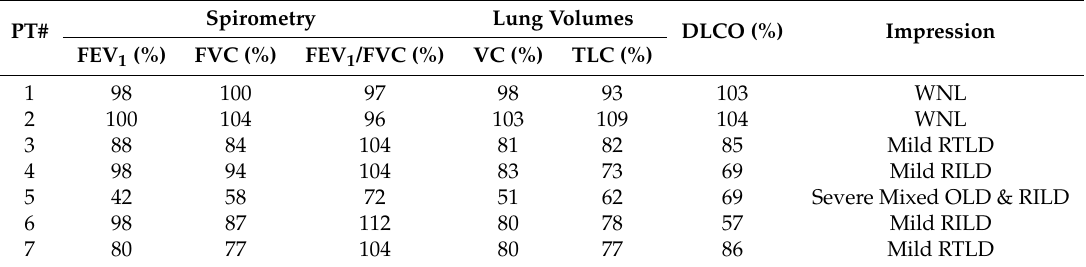
Table 3. Pulmonary function test findings in patients undergoing biopsy.